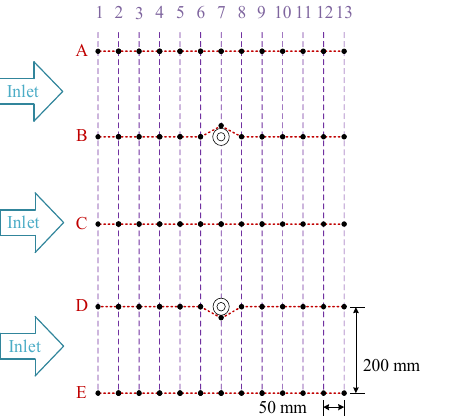
Figure 6. The relative position of temperature measuring points to the freezing pipes.